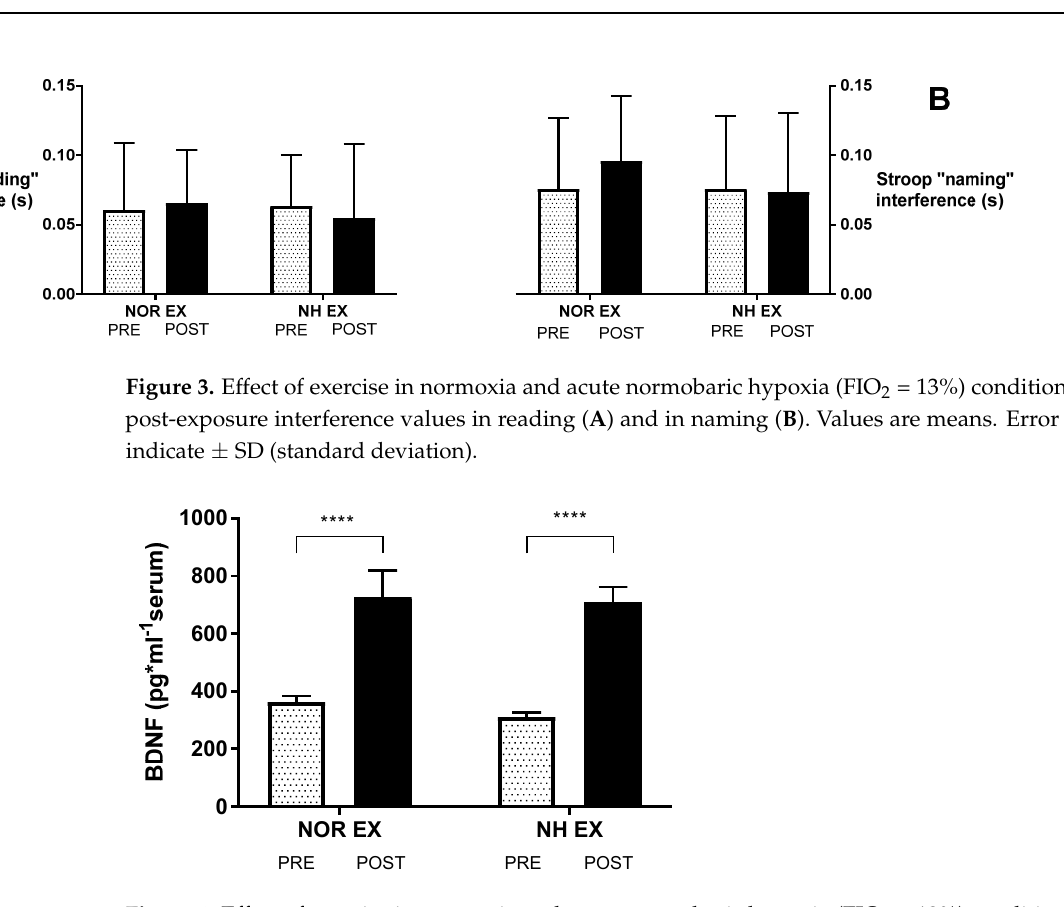
Figure 4. Effect of exercise in normoxia and acute normobaric hypoxia (FIO 2 = 13%) conditions on post-exposure serum BDNF concentration. Values are means. Error bars indicate ± SD. **** p < 0.0001.